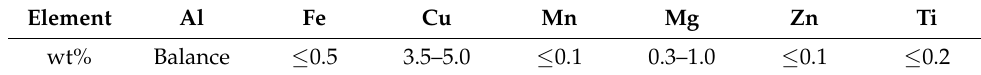
Table 2. The mechanical properties of the Al-F and Al-NF aluminum alloys.